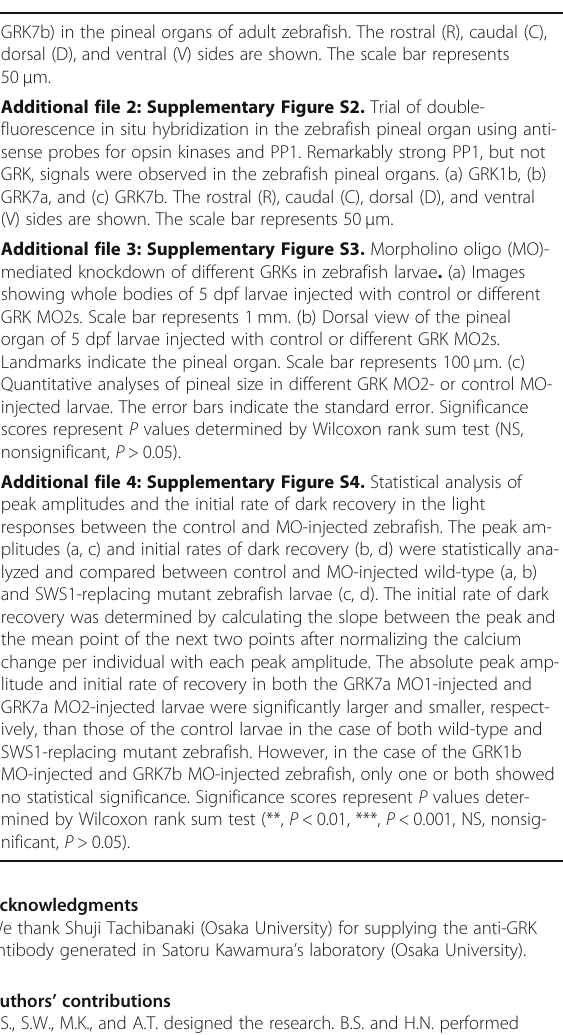
Additional file 1: Supplementary Figure S1. In situ hybridization of opsin kinases in the zebrafish pineal organ. In situ hybridization showing the mRNA expression of different opsin kinases (GRK1b, GRK7a,